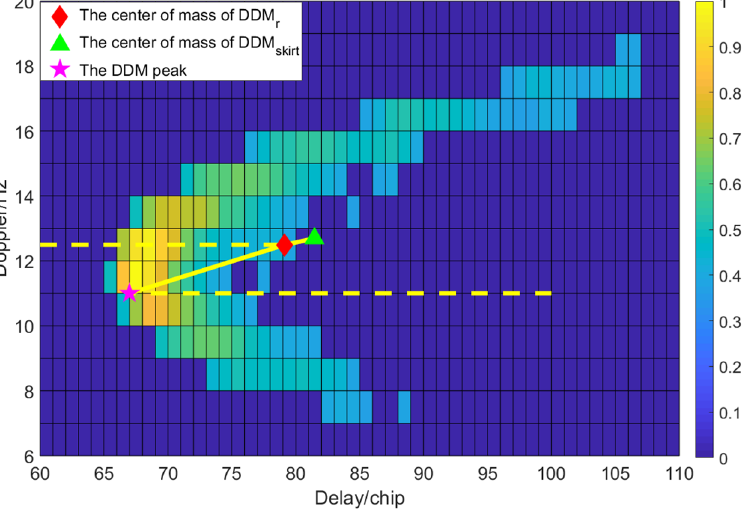
Figure 3. Extracting feature parameters of the geometric relationships φ 1 and φ 2 from the DDM of a 180° wind direction.